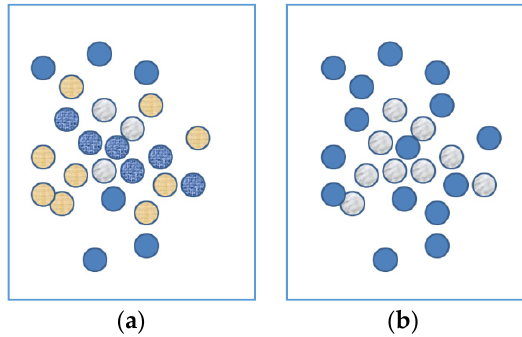
Figure 1. ( a ) Image containing capital letter A; ( b ) image containing capital letter A.